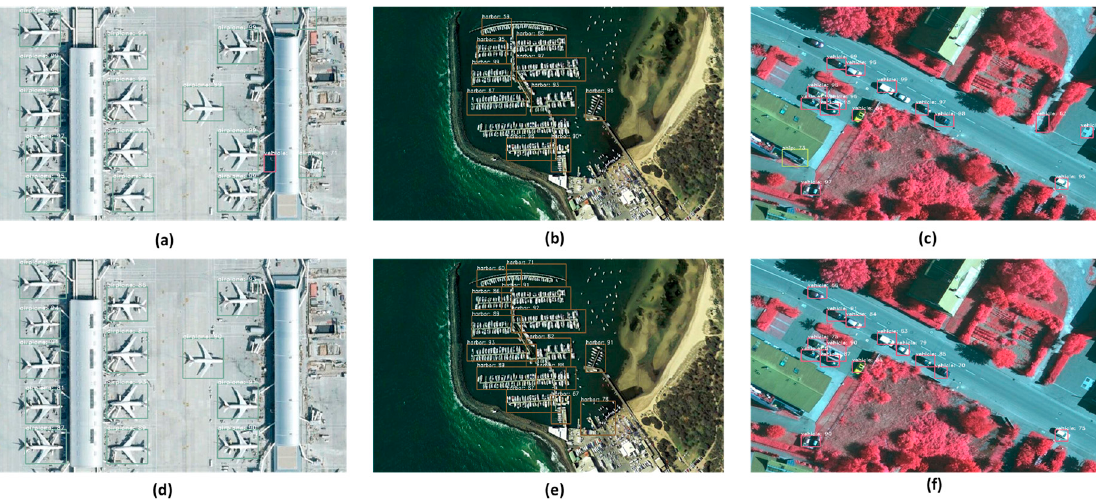
Figure 9. Detection results of Faster RCNN and proposed method. ( a – c ) denotes the results of Faster RCNN with ResNet50; ( d – f ) denotes the results of proposed method; ( a – f ) show the detection results of airplanes, harbors, vehicles respectively.